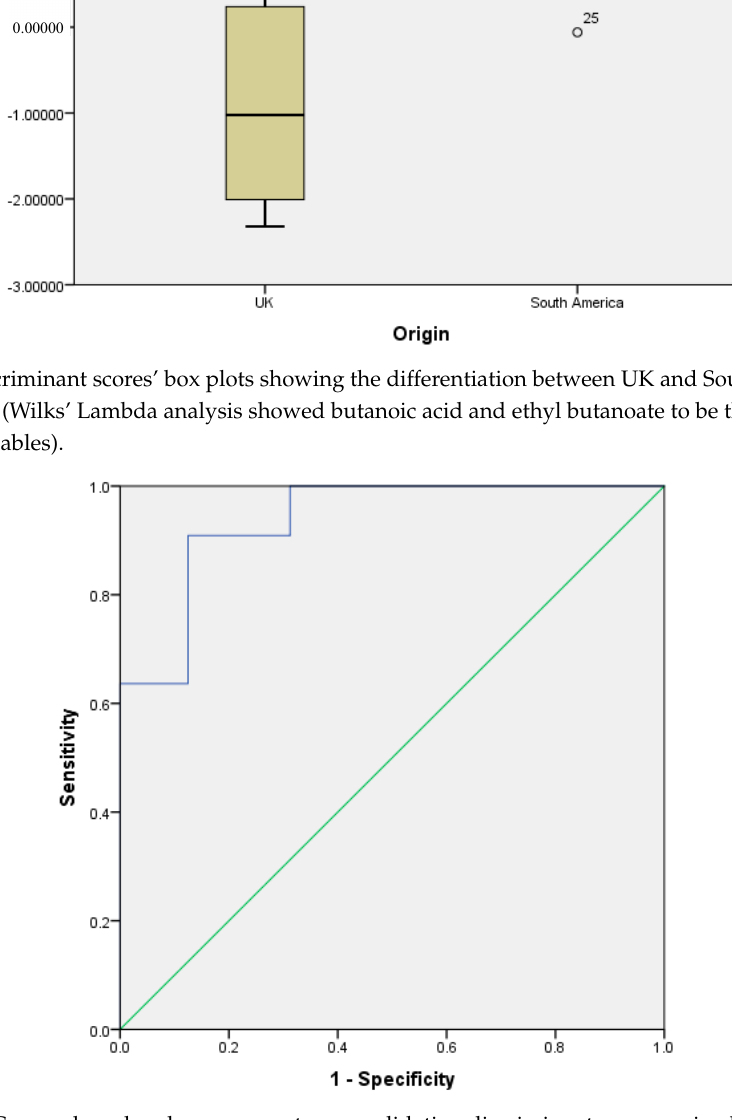
Figure 2. ROC curve based on leave-one-out cross validation discriminant scores, using butanoic acid and ethyl butanoate for different UK and South American stool samples.